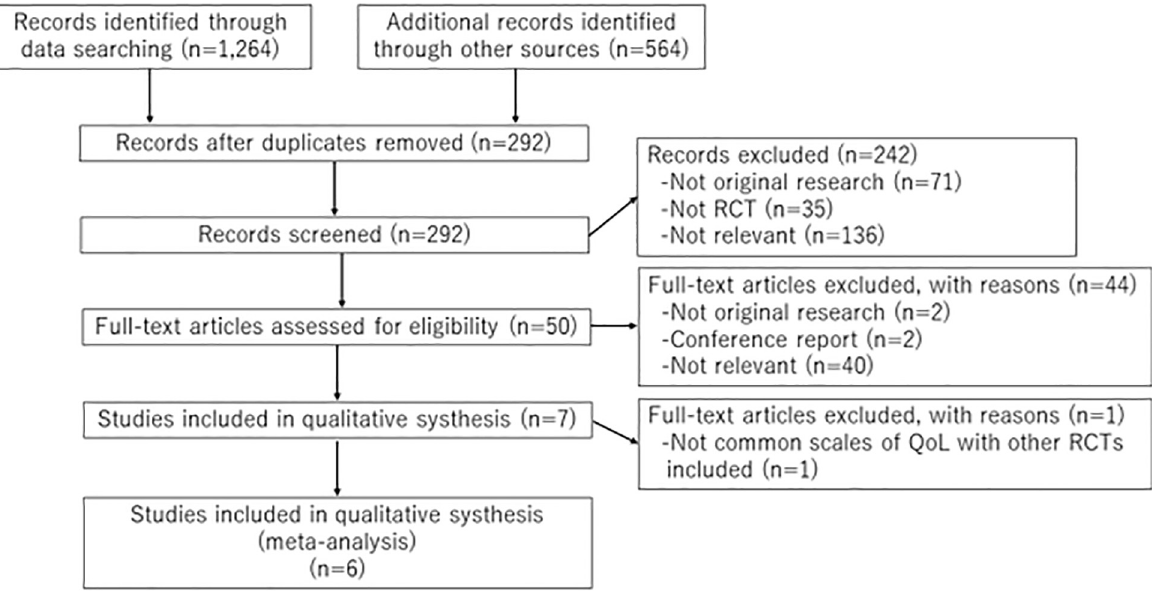
Fig 1. Process of study